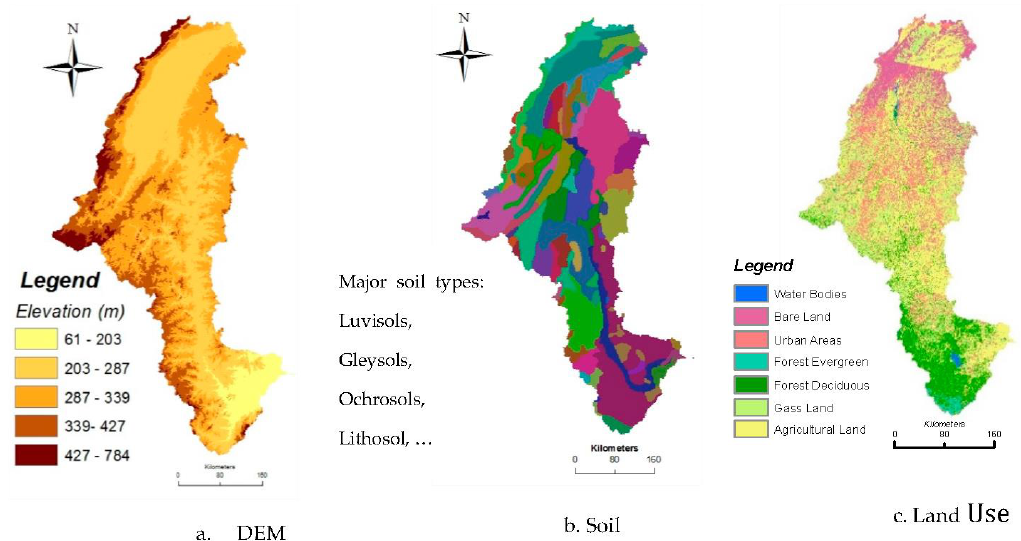
Figure 2. Geographical Information System (GIS) and Satellite Input Data.